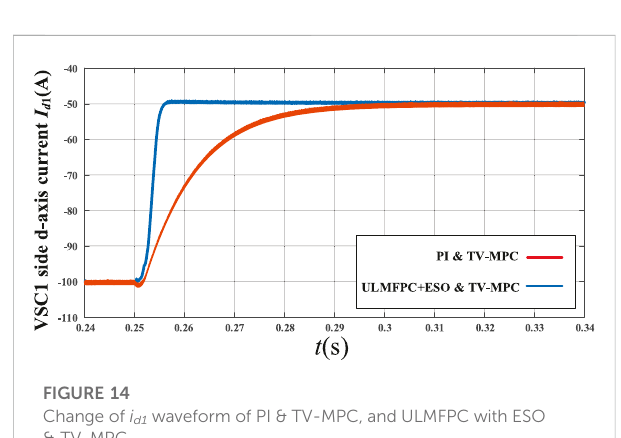
Change of i d1 waveform of PI & TV-MPC, and ULMFPC with ESO & TV-MPC.